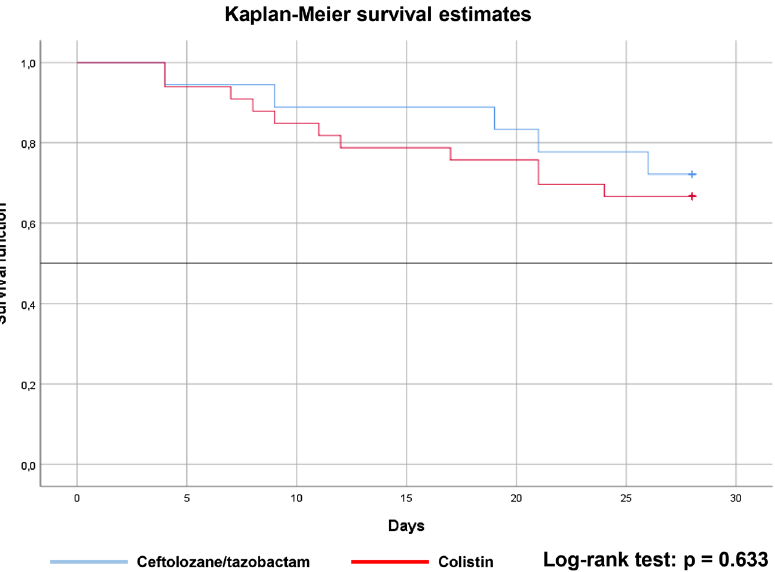
Figure 2. Survival curves for the ceftolozane/tazobactam and colistin